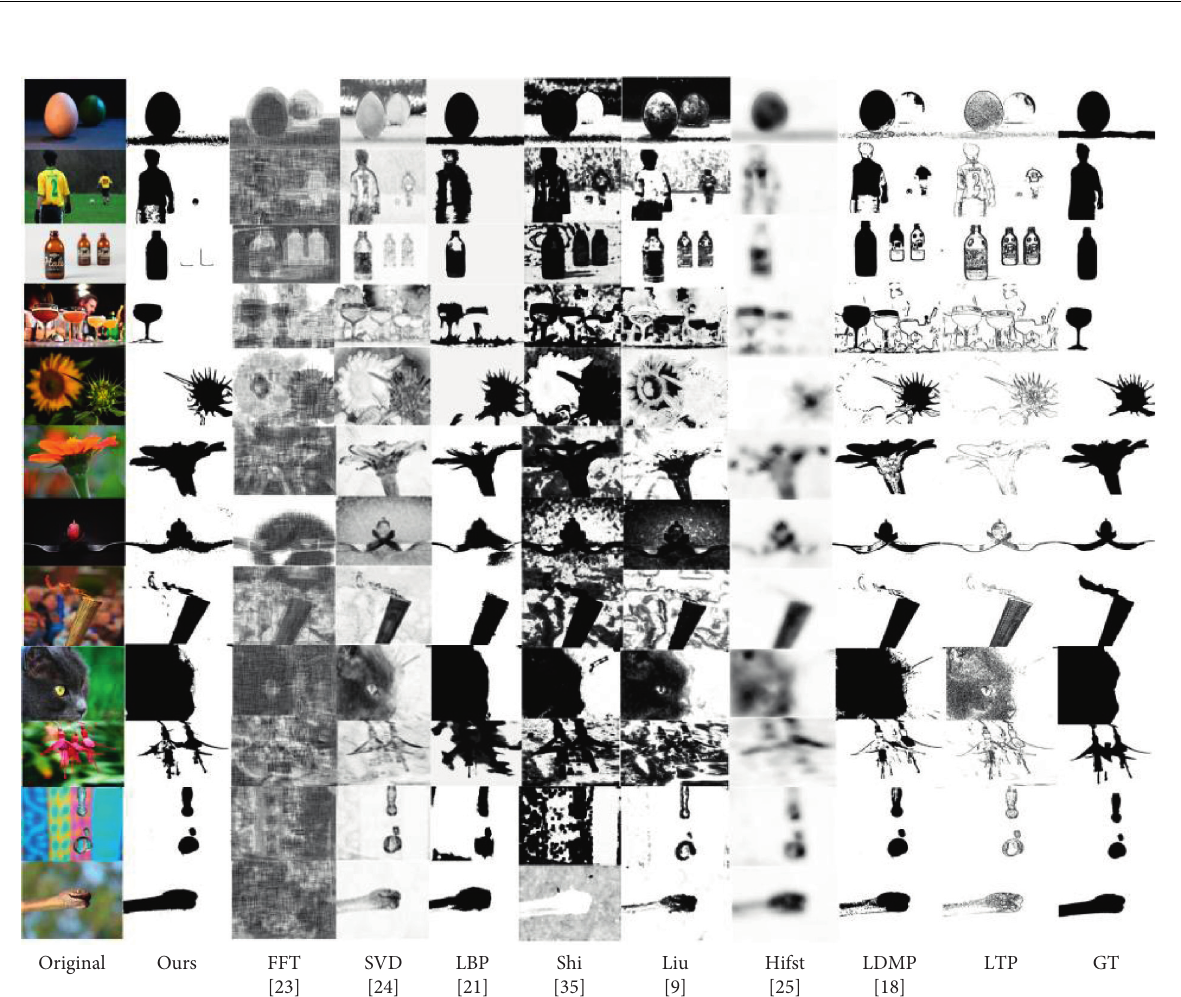
Figure 5: Visual comparison of the proposed method against comparative methods on the Shi